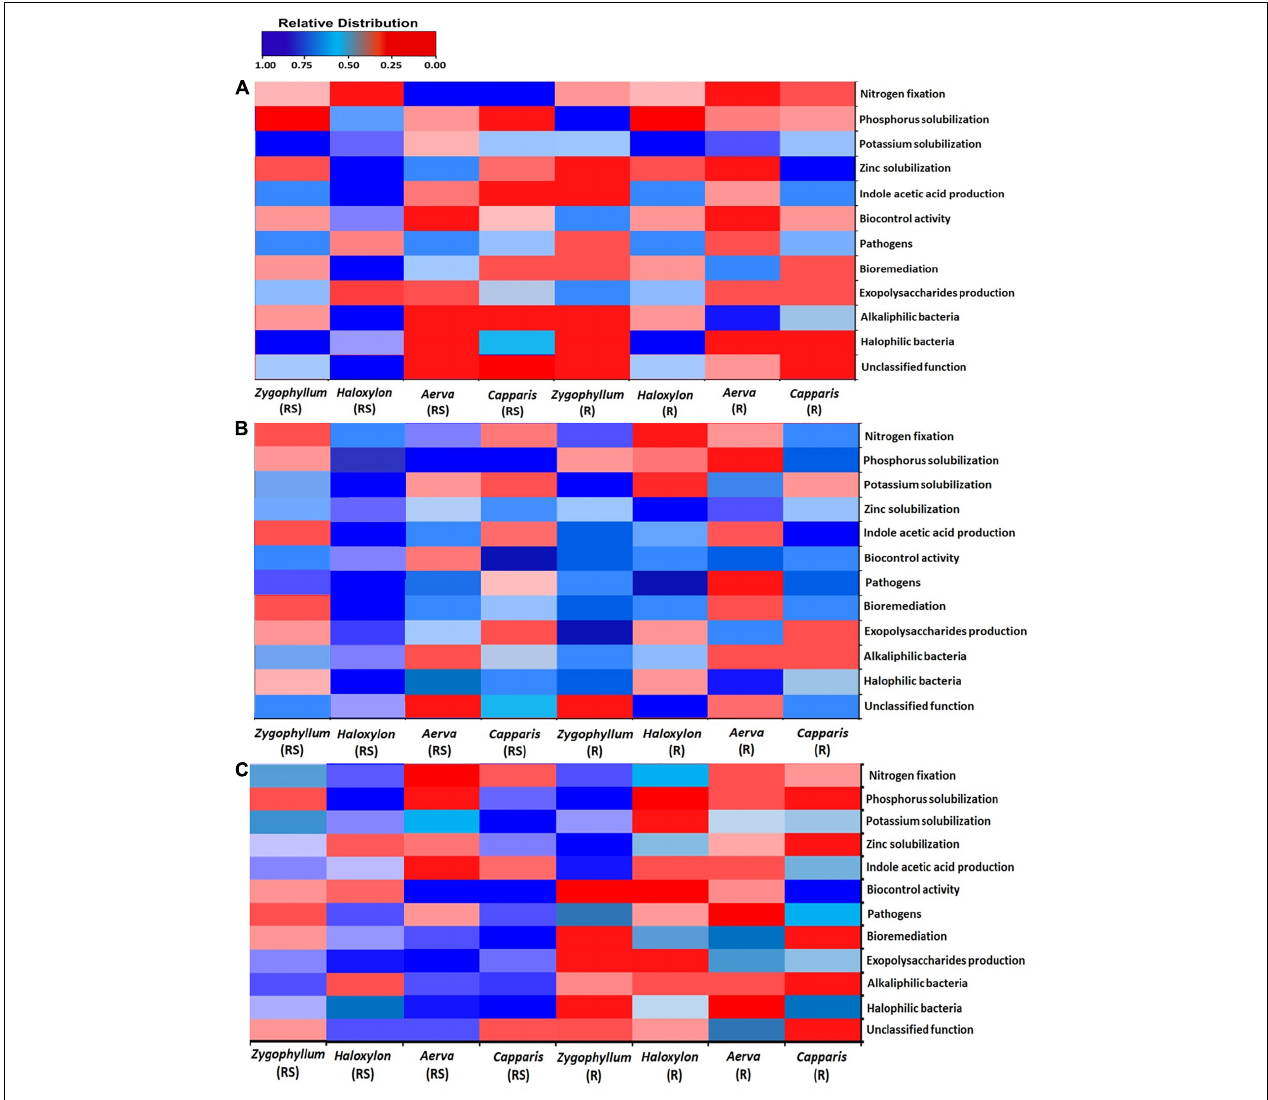
FIGURE 8 | Bacterial linked to different functional categories in the rhizosphere (RS) and root endosphere (R) of desert halophytes collected from the three sites; (A) Site 1, (B) Site 2, and (C) Site